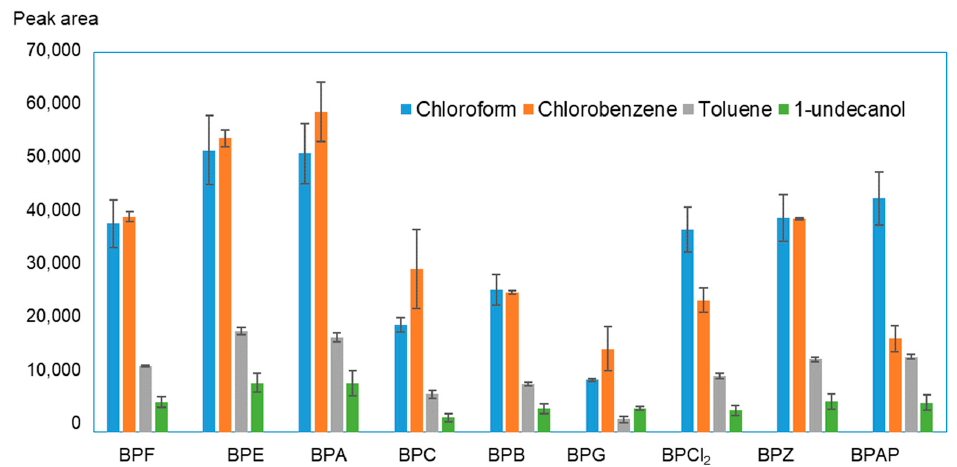
Figure 1. Influence of type of solvent on BP extraction